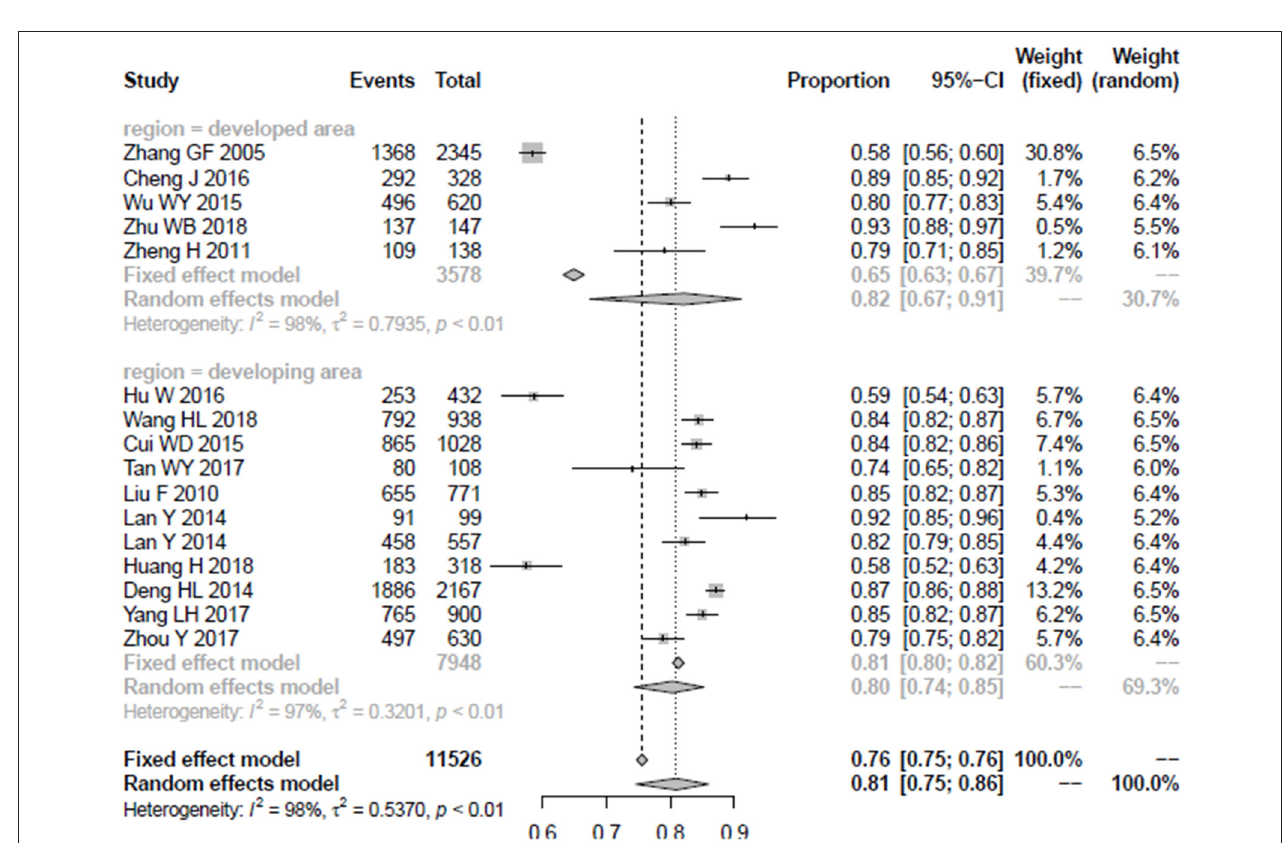
FIGURE 3 | The forest plot of awareness rate among developed and developing regions.